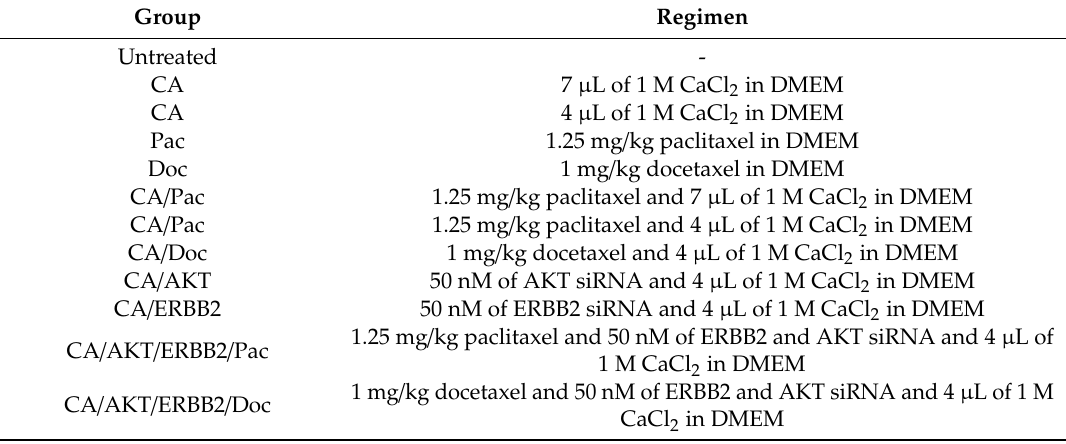
Table 3. Treatment groups used for in vivo